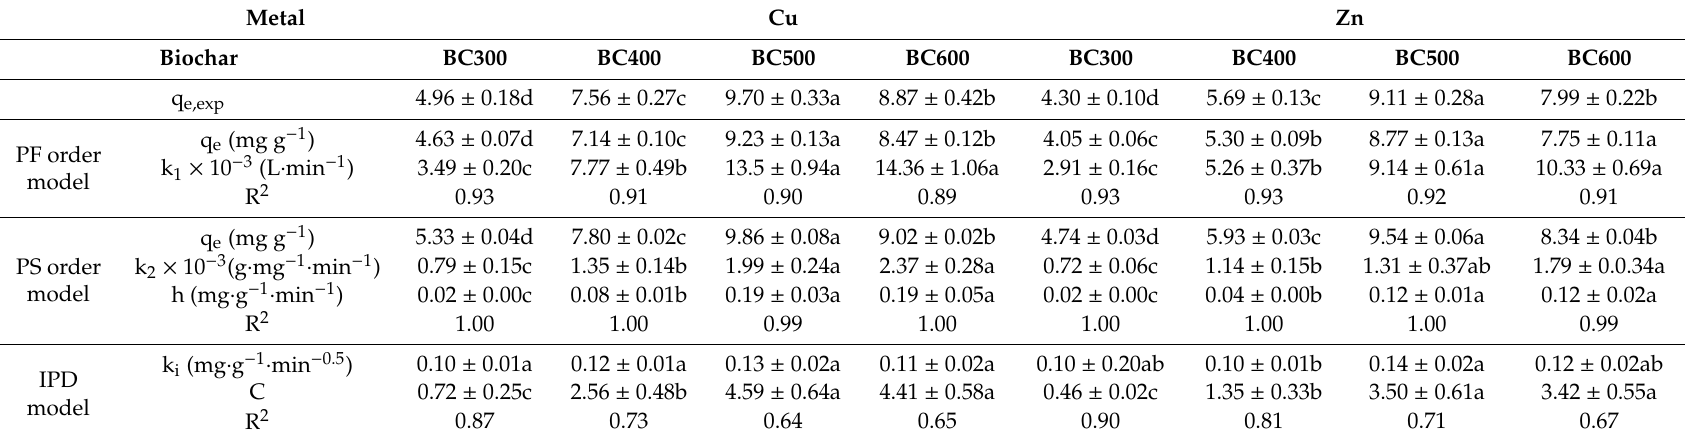
Table 3. Parameters of pseudo-first order model, pseudo-second order model, and intraparticle di ff usion model for Cu(II) and Zn(II) adsorption by